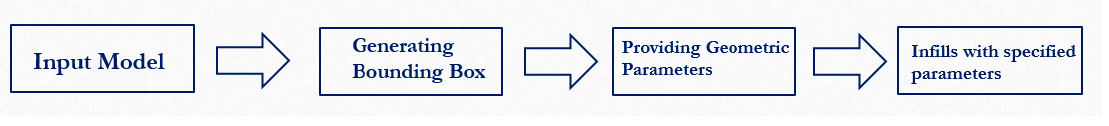
Figure 1. The system pipeline of our method.